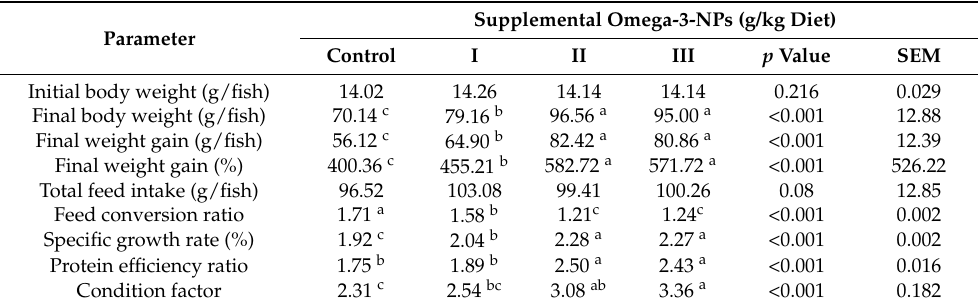
Table 4. Growth performance parameters of Nile tilapia ( O. niloticus ) fed diets enriched with different levels of omega-3